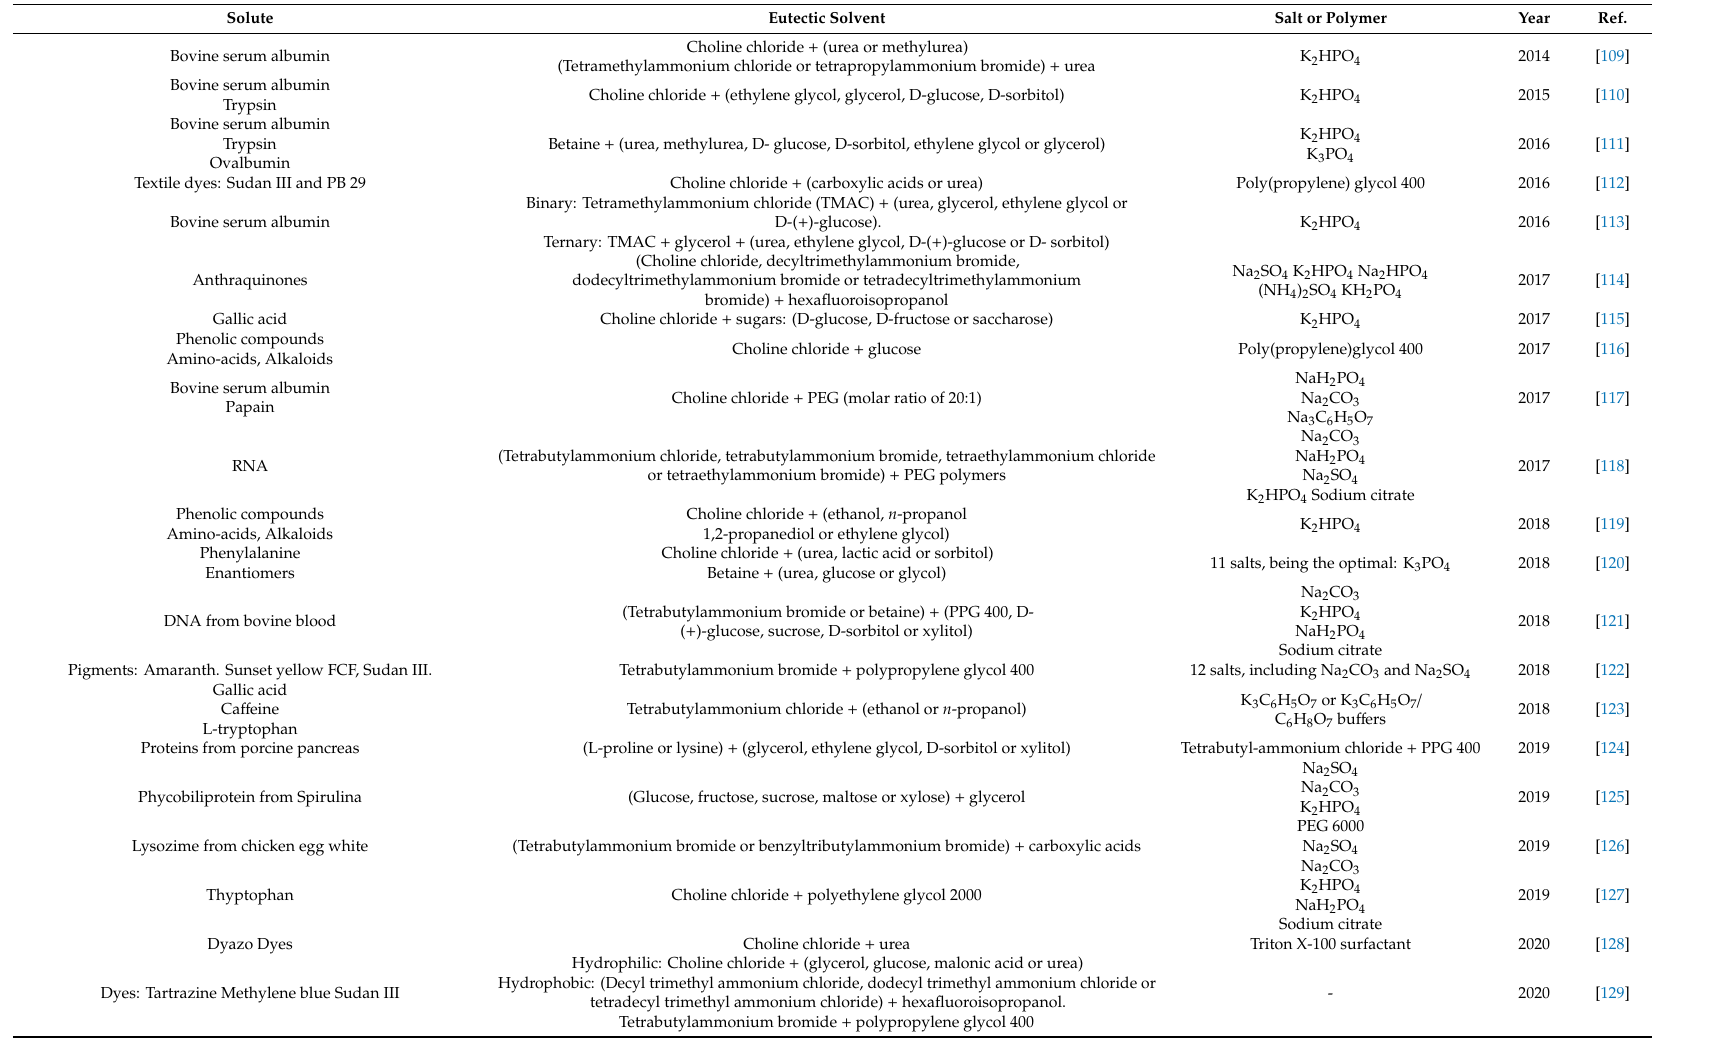
Table 7. Formation of Aqueous Biphasic Systems (ABS) with Eutectic Solvents Solute Bovine serum albumin Trypsin Bovine serum albumin Trypsin Ovalbumin Textile dyes: Sudan III and PB 29 Choline chloride + (carboxylic acids or urea) Binary: Tetramethylammonium chloride (TMAC) + (urea, glycerol, ethylene glycol or Bovine serum albumin D-( + )-glucose).